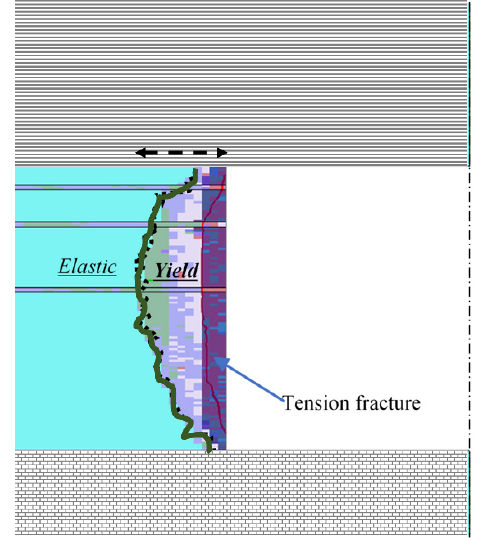
Figure 11. Bow-shaped rib failure process [34].